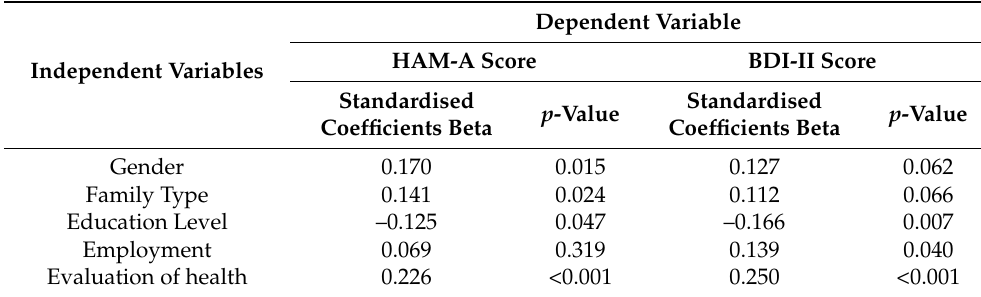
Table 4. Assessment of factors affecting HAM-A and BDI-II scores among Jordanian fertile couples ( N =